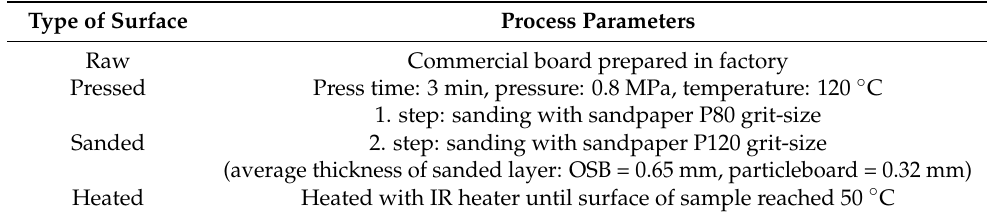
Table 2. Parameters of surface